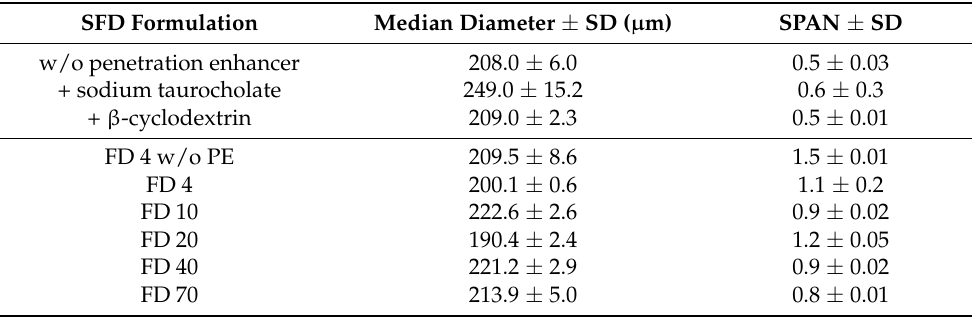
Table 1. Particle size distribution of insulin or FITC-dextrans loaded SFD